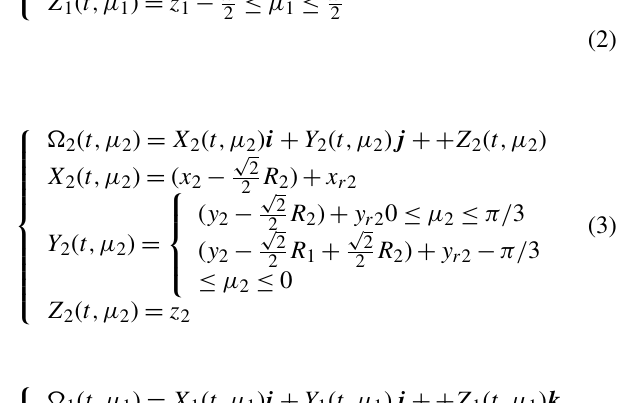
Figure 1. Coordinate systems of the gear drive.